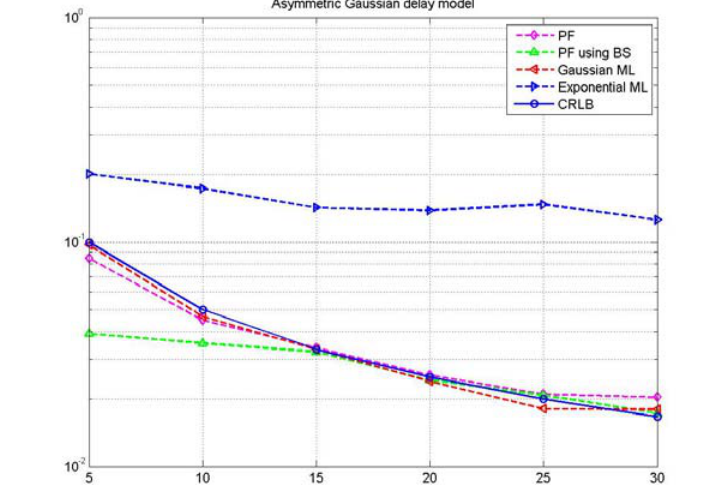
Figure 8. MSEs of clock offset estimators for asymmetric Gaussian random delay ( 1   ).